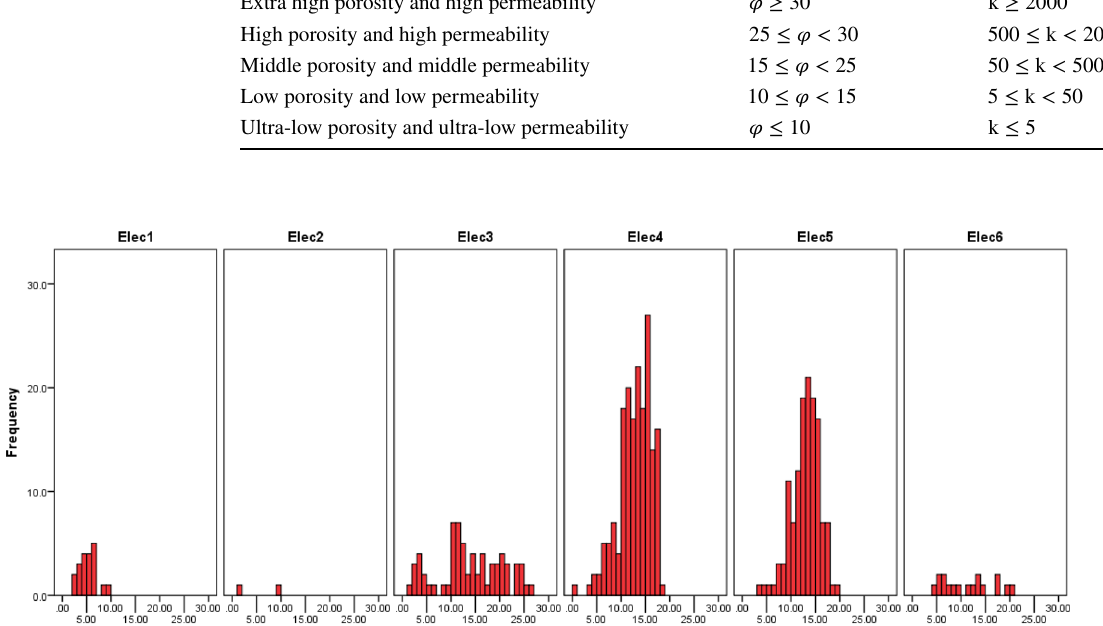
Fig. 2 Overall distribution of permeability (1 × 10 −3 μm 2 ) Table 2 Criterion for classification of Clastic reservoir physical property